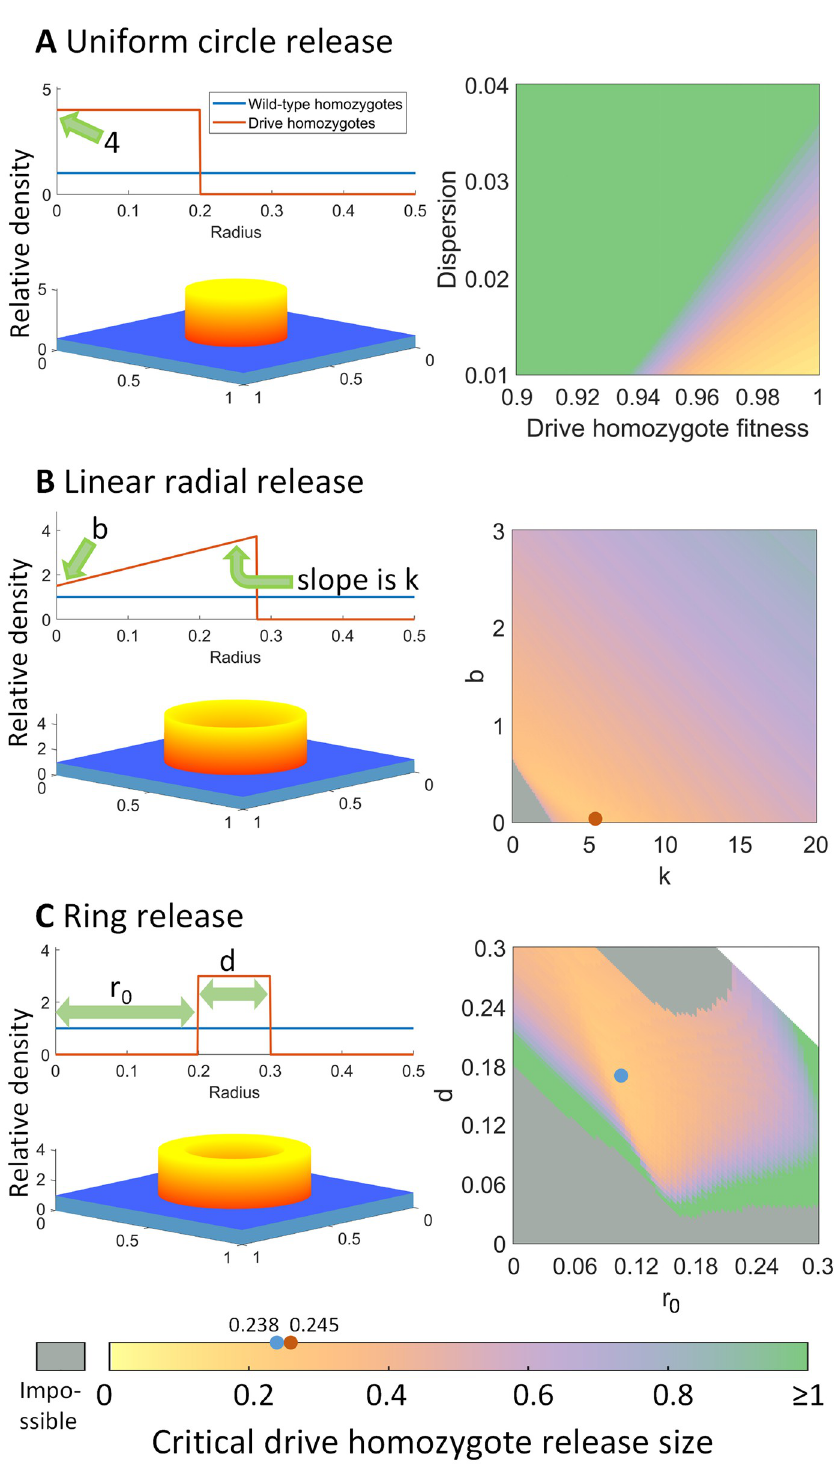
Fig 5. Spatial circular release scenarios for the CifAB drive. The heatmaps show the critical release size, which is the number of individuals required (expressed as a multiple of the carrying capacity of one unit area) for the drive to successfully establish and spread. Dots mark minimum critical release sizes. A : A fixed release frequency of 80% in the release area. As the critical release size increases, the release radius increases to support the greater number of drive individuals. B : A radial release pattern with varying density, keeping fitness at 1 and dispersion at 0.03. The